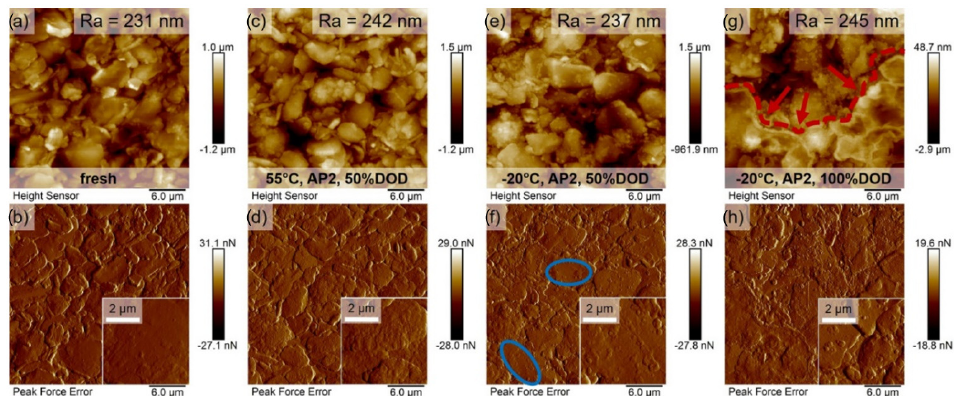
Figure 12. The height images are on the top and PEF images on the bottom: ( a , b ) fresh anode; ( c , d ) cell aged at 55 °C using AP 2 , 50% DOD; ( e , f ) cell aged at − 20 °C using AP 2 , 50% DOD; ( g , h ) cell aged at − 20 °C using AP 2 , 100% DOD. The blue circles emphasize the flat graphite, and the red arrows are using to present Li plating [64].